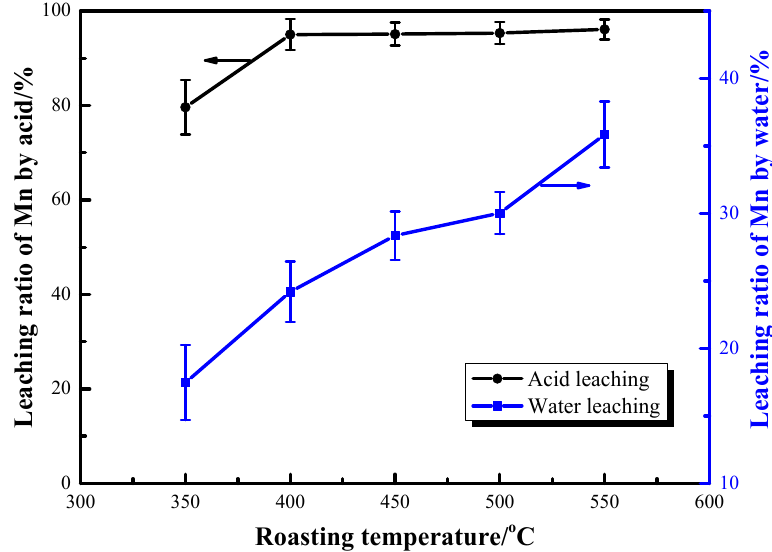
Figure 11. Effect of roasting temperature on the leaching ratio of Mn (30 min, S 2 /MnO 2 : 0.5).